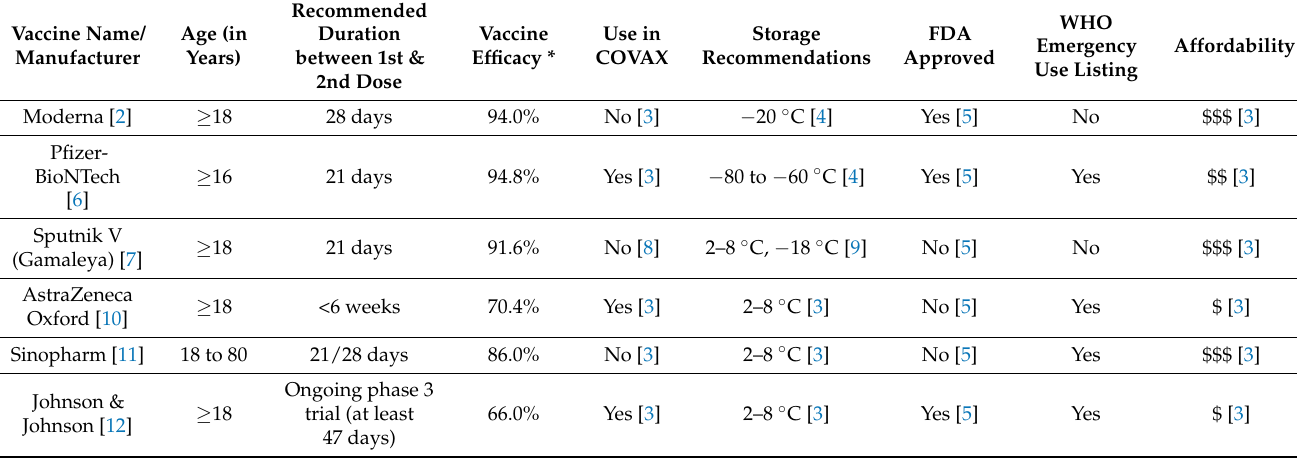
Table 1. Summary of COVID-19 vaccines currently being used (Supplementary Table